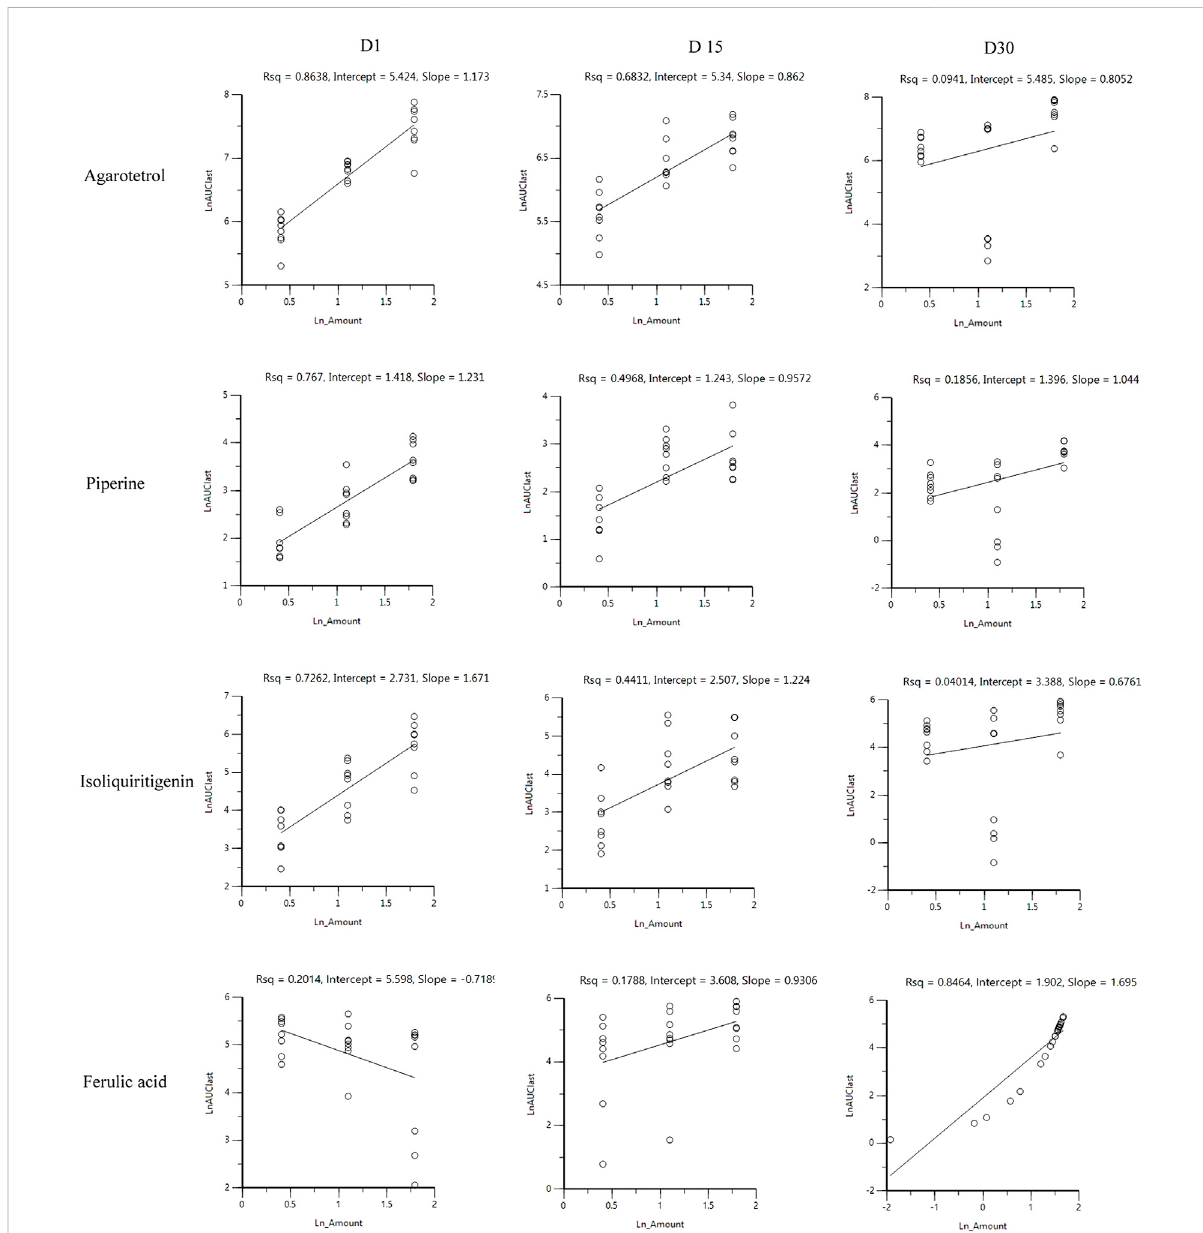
FIGURE 4 Linear relationship diagram between the logarithmic dose value and the logarithmic AUC 0-t value.